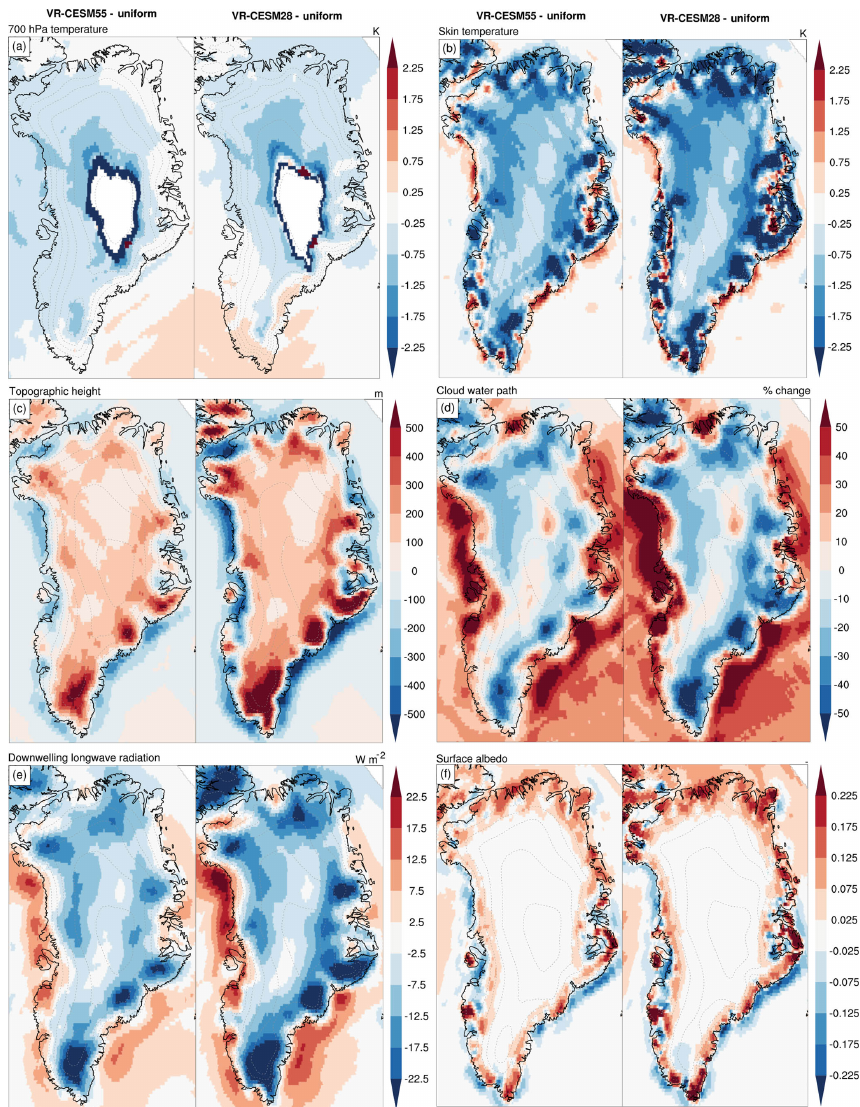
Figure 9. Summer (JJA) anomalies of atmospheric (CAM) variables over the period 1980–1999, relative to the coarse-resolution reference simulation (Uniform CESM). (a) The 700hPa air temperature (K), (b) radiative skin temperature (K), (c) CAM topographic height (m), (d) cloud water path (% change), (e) surface downwelling longwave radiation (Wm − 2 ), and (f) surface albedo (-). Prior to subtraction, all data have been regridded to a common regular mesh of 0.25 ◦ using bilinear interpolation. Therefore, these anomalies should be interpreted with some caution since they contain interpolation errors. The “sinking oceans” in (c) are explained by the smoothing operator applied to CAM topography, the imprint of which is much wider at low resolution than it is at high resolution (cf. Fig. 2 and Sect.